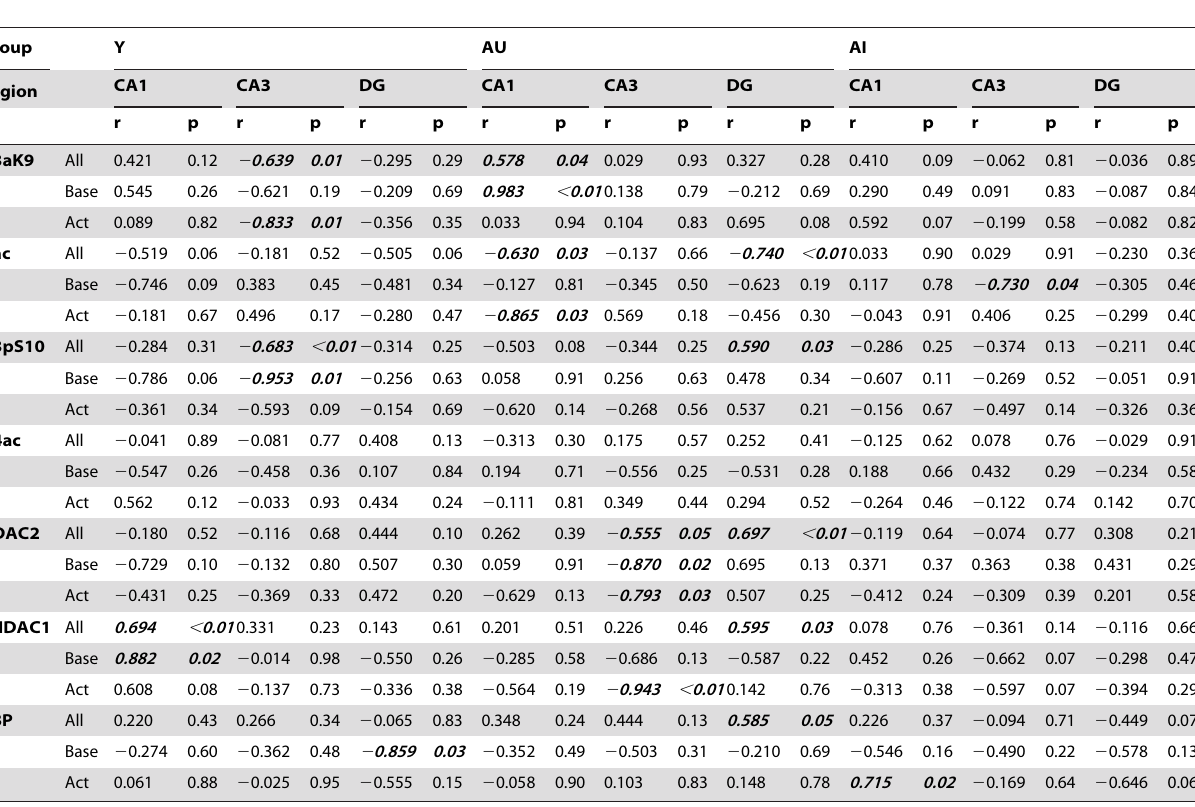
Table 1. Pearson r correlation coefficients and associated p-values for the learning index scores from initial behavioral characterization in relation to the chromatin modification quantification in Y, AU and AI groups. Significant correlations (p # 0.05) are bolded and italicized.